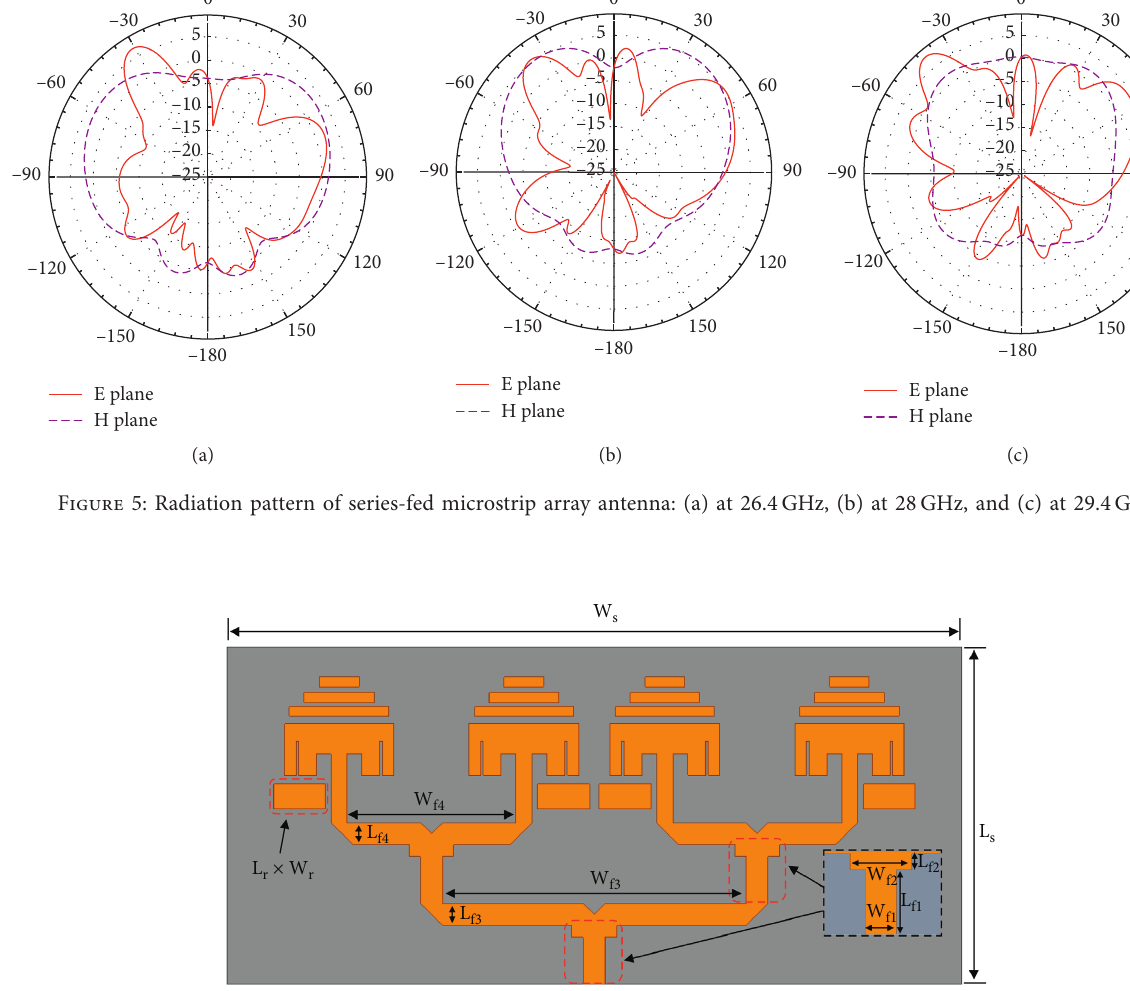
Figure 6: Geometry of corporate-fed microstrip array antenna.